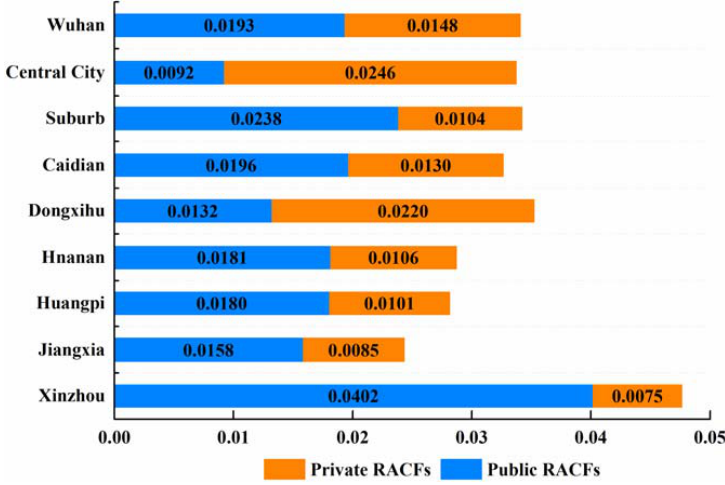
Figure 7. Average accessibility score to RACFs in Wuhan.